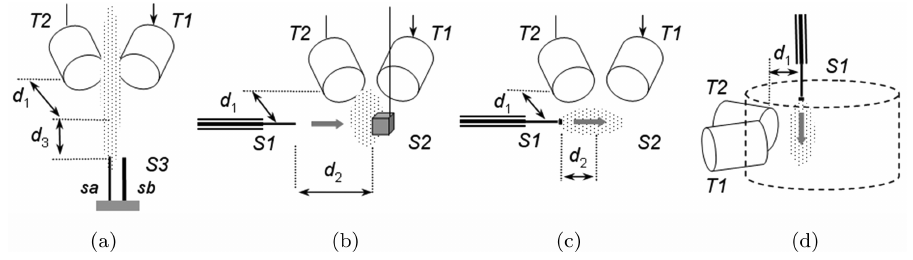
Fig. 2. Setup of transducers for various